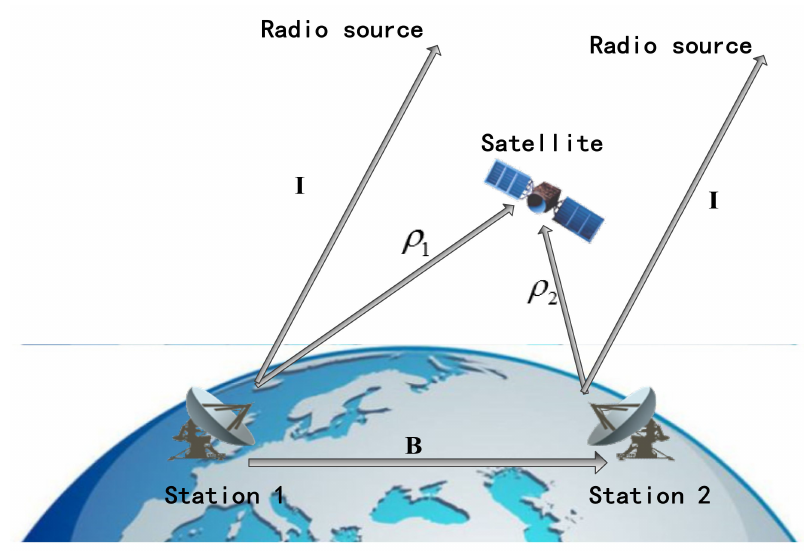
Figure 2. Observation mode of